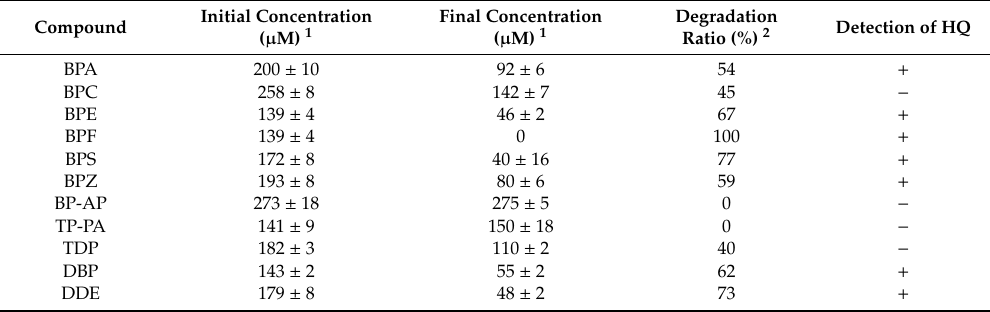
Table 1. Degradability of BPs by P. putida KT2440 harboring pBNMOA-F ( nmoA ).